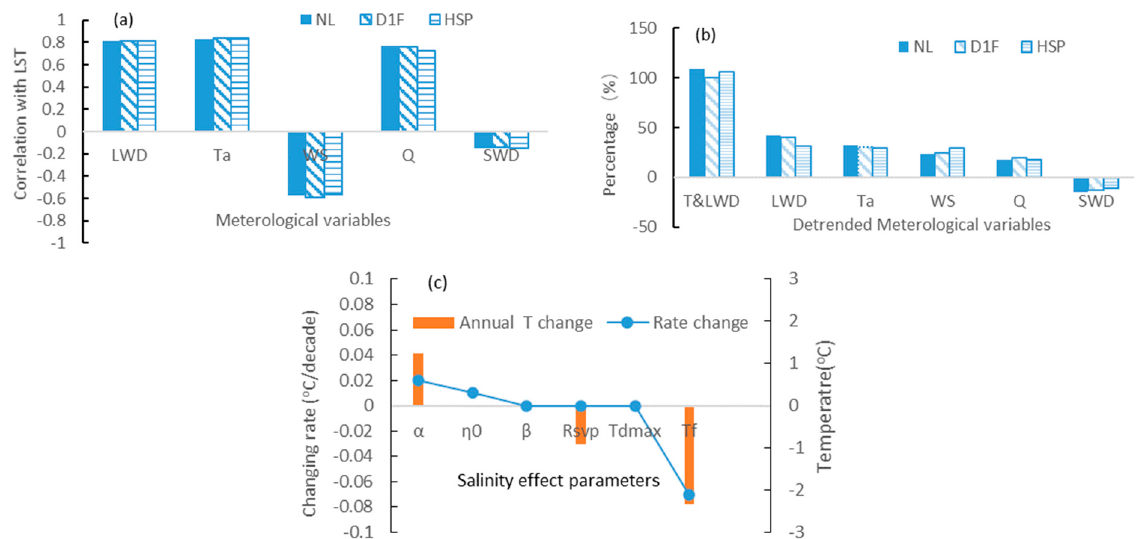
Figure 7. Correlations between the meteorological variables and LSWT ( a ), the percentage difference of LSWT warming rate between the control simulation S-(lake) and the sensitivity simulations S- (Lake)-d (variable) in NL, D1F, and HSP ( b ), the difference of LSWT and the warming rate between the S-HSP control simulation and S-HSP-(parameter of salinity effect) sensitivity simulations ( c ).